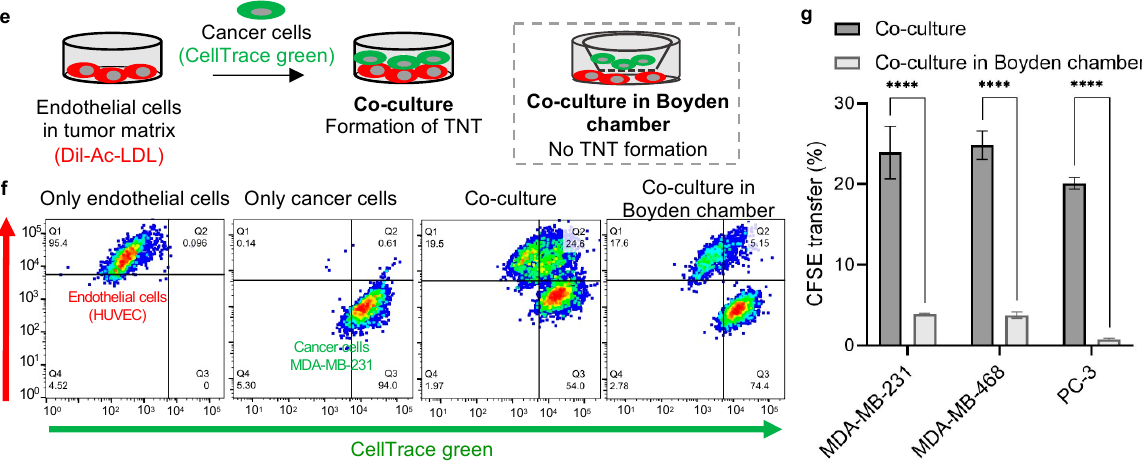
Figure 1. Communication of cancer cells with endothelium and phenotypic transition. ( a ) Schematic representation of the monoculture of metastatic cancer cells (MDA-MB-231) in the 3D tumor matrix, forming 3D cellular aggregates or mammosphere-like structures. ( b ) Schematic for cancer cells adopting an elongated phenotype when co-cultured with preformed endothelium in the 3D tumor matrix. The elongated phenotype of cancer cells aligns with the endothelial layer, forming nanoscale communications with the endothelial cells. ( c ) Representative image of the formation of mammospheres during the monoculture of cancer cells (MDA-MB-231) in the 3D tumor matrix in the absence of endothelium. MDA-MB-231 cancer cells were stained with CellTrace red and cultured on a Matrigel (tumor matrix) coated plate for 24 h. The cells were fixed, actin filaments stained with phalloidin green, and the nuclei were counterstained with DAPI. The yellow signal from the image originates from the overlapping of CellTrace red stained cancer cell and phalloidin green staining. ( d ) Representative image of the co-culture of cancer cells (MDA-MB-231) with preformed endothelium of human umbilical vein endothelial cells (HUVECs) for 24 h in the 3D tumor matrix. HUVECs (unstained) were cultured on Matrigel-coated plate for 5–6 h to form the endothelial network. After that, CellTrace red stained cancer cells were added to the preformed endothelium. After 24 h of co-culture, the cells were fixed, and actin filaments were stained with phalloidin green, and the nuclei were counterstained with DAPI. The yellow and green stained cells represent the cancer cells (CellTrace red and phalloidin green stained) and endothelial cells (phalloidin green stained), respectively. The image on the left side reveals the cancer cells (yellow) have transformed into an elongated phenotype and aligned with the preformed endothelial layer (green). The right-side image shows the physical communication between the cancer cells and the endothelial cells via tunneling nanotubes (yellow arrows). The phalloidin staining signifies the presence of actin in the nanotubes. The monochromatic (red) image represents the cancer cells (red fluorescence) obtaining an elongated phenotype, as compared with the mammosphere-like structure in the monoculture of cancer cells in the 3D tumor matrix, by forming nanotubular structures with the endothelium and invaginating into the endothelial network. ( e ) Schematic representation of the experimental design to evaluate the transfer of cytoplasmic contents from cancer cells to